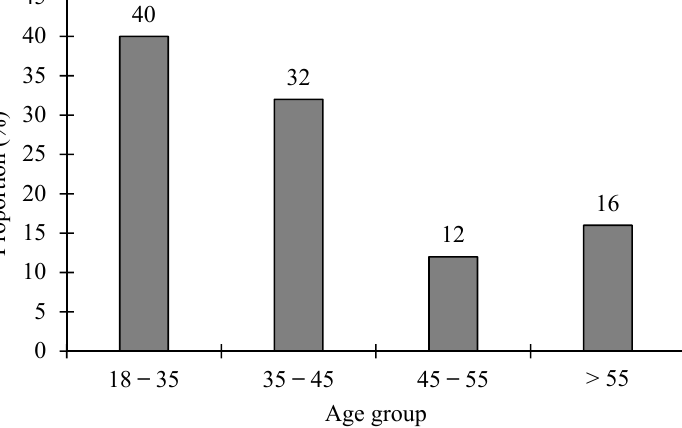
Figure 7. Distribution of cocoa producers by age group in Biankouma region.